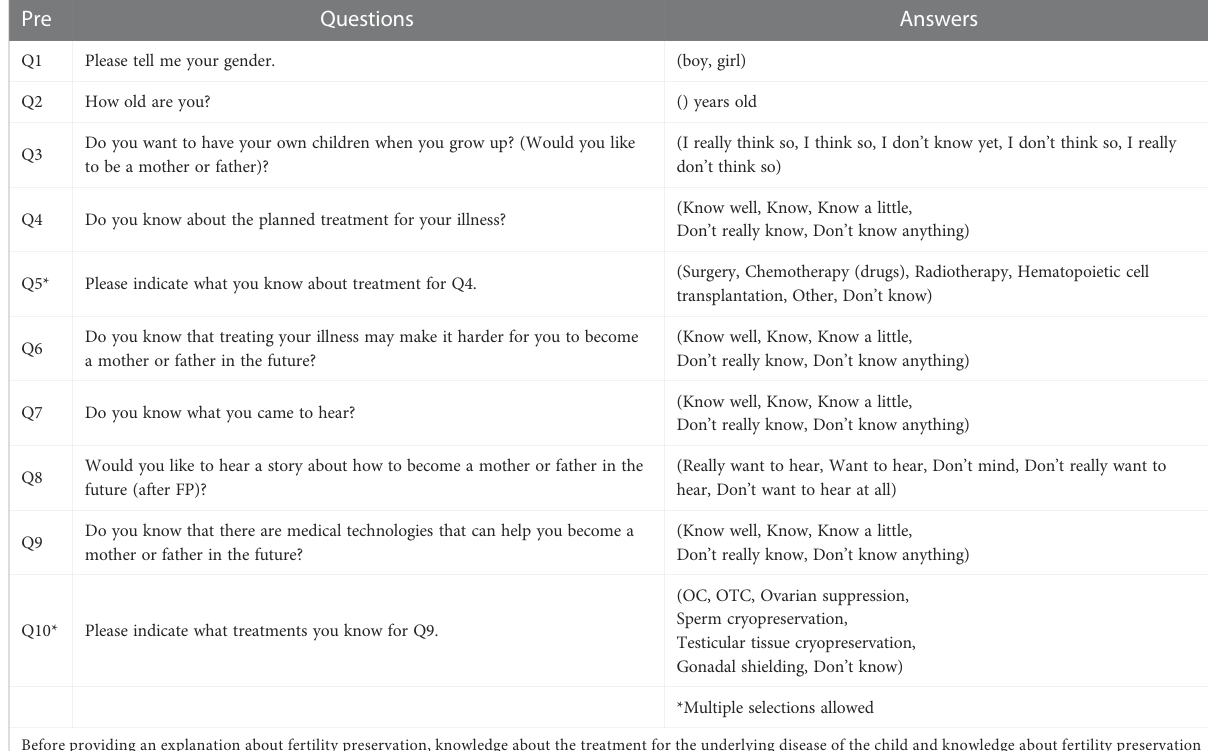
TABLE 1 Questionnaire pre-explanation of fertility preservation.